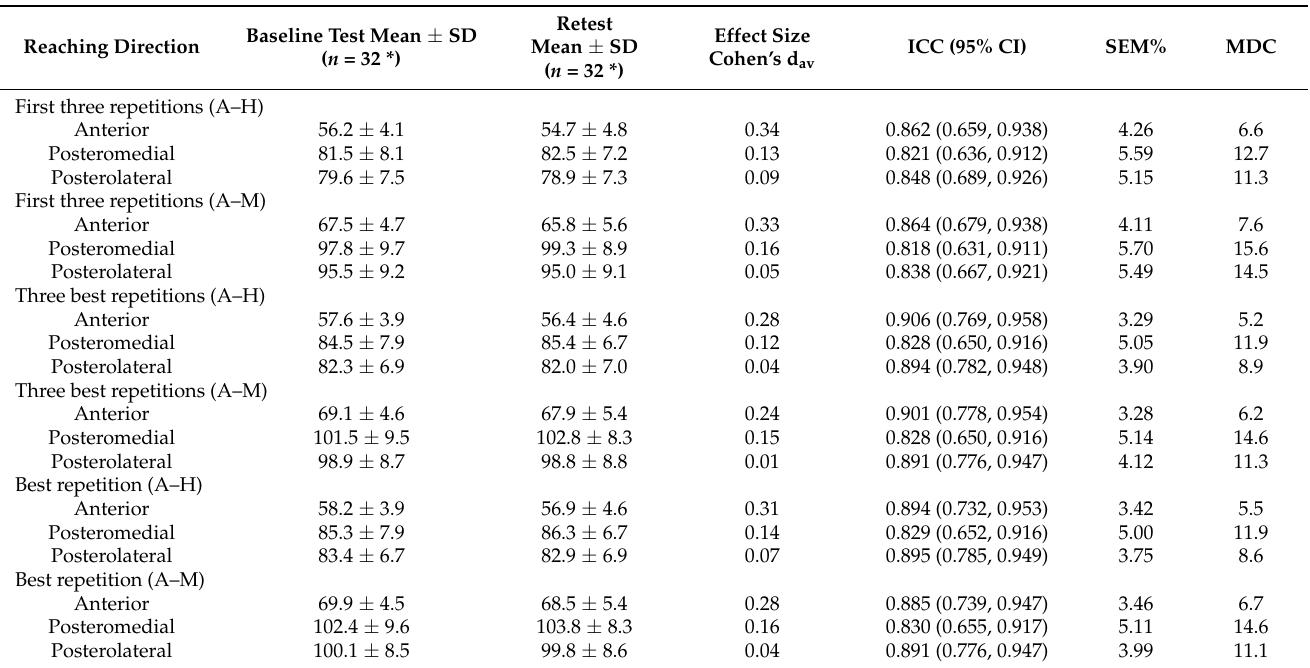
percentage; MDC, minimal detectable change. * Both legs results included in the